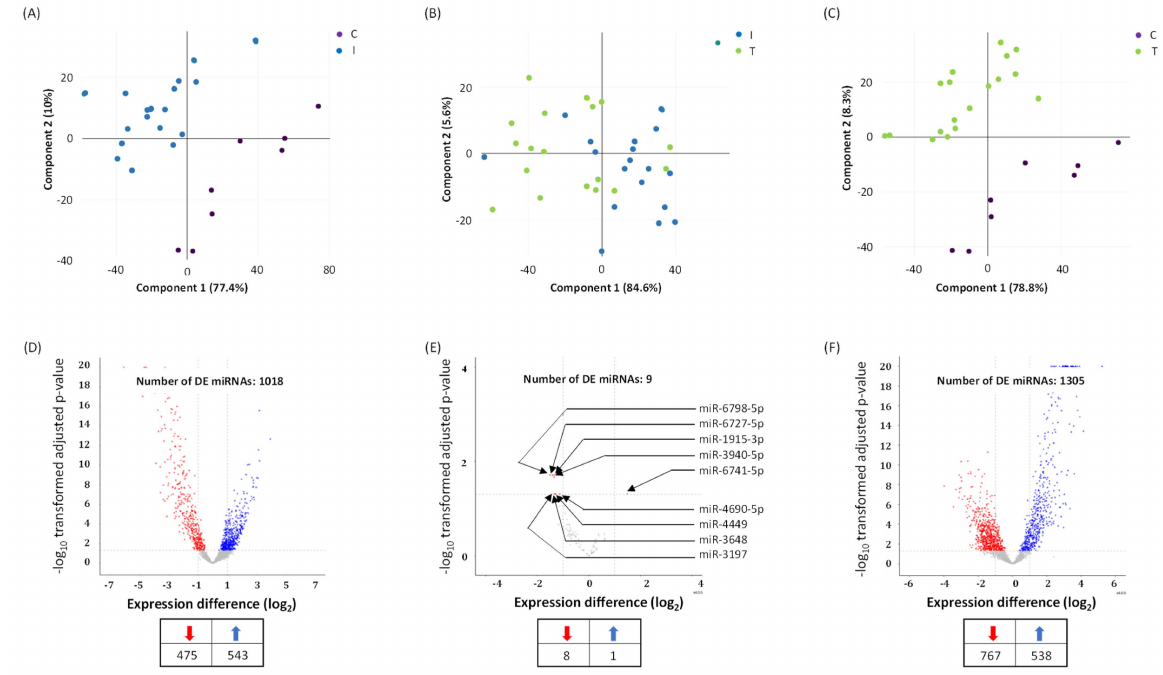
Figure 1. Differentially expressed (DE) miRNAs in COVID-19 patients with moderate-severe disease (I) compared to treated (T) and healthy participants (C). ( A – C ) Principal component analysis (PCA) plot showing transcriptome differences between miRNA expression in I, T, and C group of COVID- 19 patients. Each dot represents one of the total number of samples (12 samples from I and T group of COVID-19 patients and 8 samples from healthy participants) used in the sequencing- based screening. ( D , E ) Volcano plot for differentially expressed miRNAs, showing distribution of significance [ − log10( p -value)] vs. fold change [log2(fold change)] for all genes. The red and blue dots represent downregulated and upregulated miRNA expression in I vs. C groups ( D ); I vs. T groups ( E ); and T vs. C groups ( F ), respectively. C denotes healthy volunteers, I denotes COVID-19 patients treated with remdesivir (an antiviral) plus dexamethasone (with or without baricitinib, a Janus kinase inhibitor) on the day of hospitalization, and T denotes COVID-19 patients at 48 h post treatment. The number of DE miRNAs is listed in the table provided under panels D, E, and F. Arrows denote specific